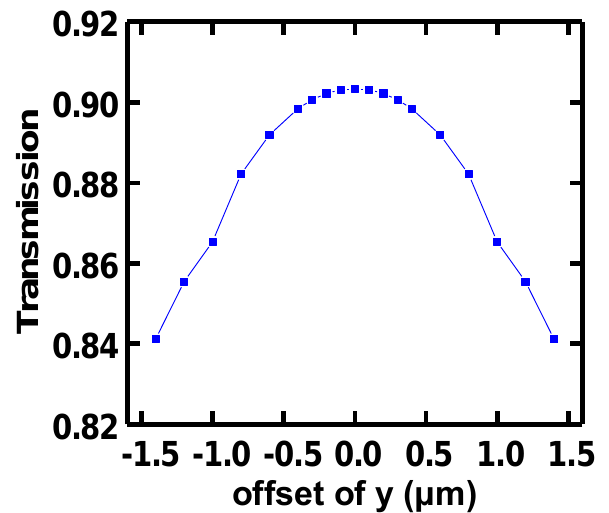
Si 3 N 4 waveguides.